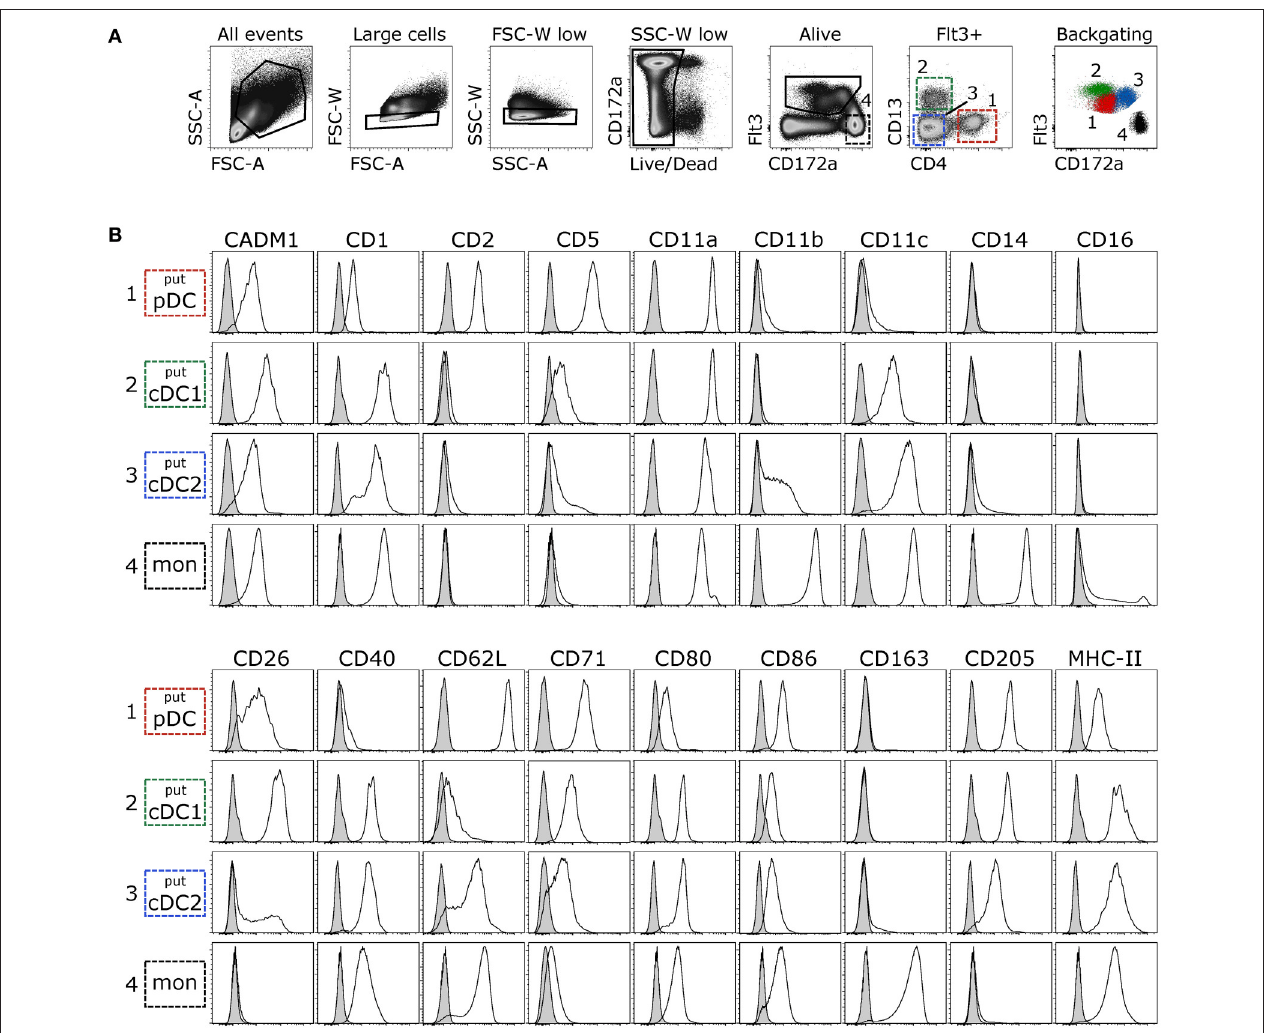
FIGURE 1 | Phenotyping of putative DC subsets. Freshly isolated PBMC were stained for flow cytometry. (A) Large cells were selected in FSC-A vs. SSC-A and, following exclusion of doublets and dead cells, Flt3 + cells (DC) and Flt3 − CD172a high cells (monocytes) were gated. Within Flt3 + cells, three subsets were distinguished based on expression of CD4 and CD13. CD4 + CD13 − putative pDC, CD4 − CD13 + putative cDC1, and CD4 − CD13 − putative cDC2. Backgating of the respective subsets illustrates expression levels of Flt3 and CD172a. (B) Empty histograms show the expression of various molecules on putative DC subsets and monocytes. Gray histograms show the FMO control. Data are representative for at least 3 animals.